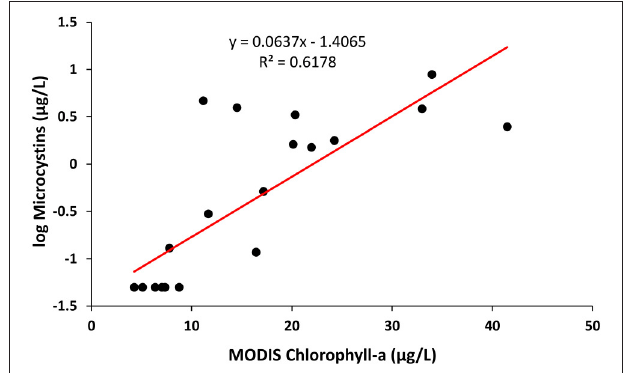
FIGURE 5 | Scatter plot showing the relationship between MODIS-retrieved chlorophyll- a with in situ -measured levels of Microcystins (log transformed) at Toledo water plant intake points from May to October, 2013. The solid lines represent the best-fit linear regression